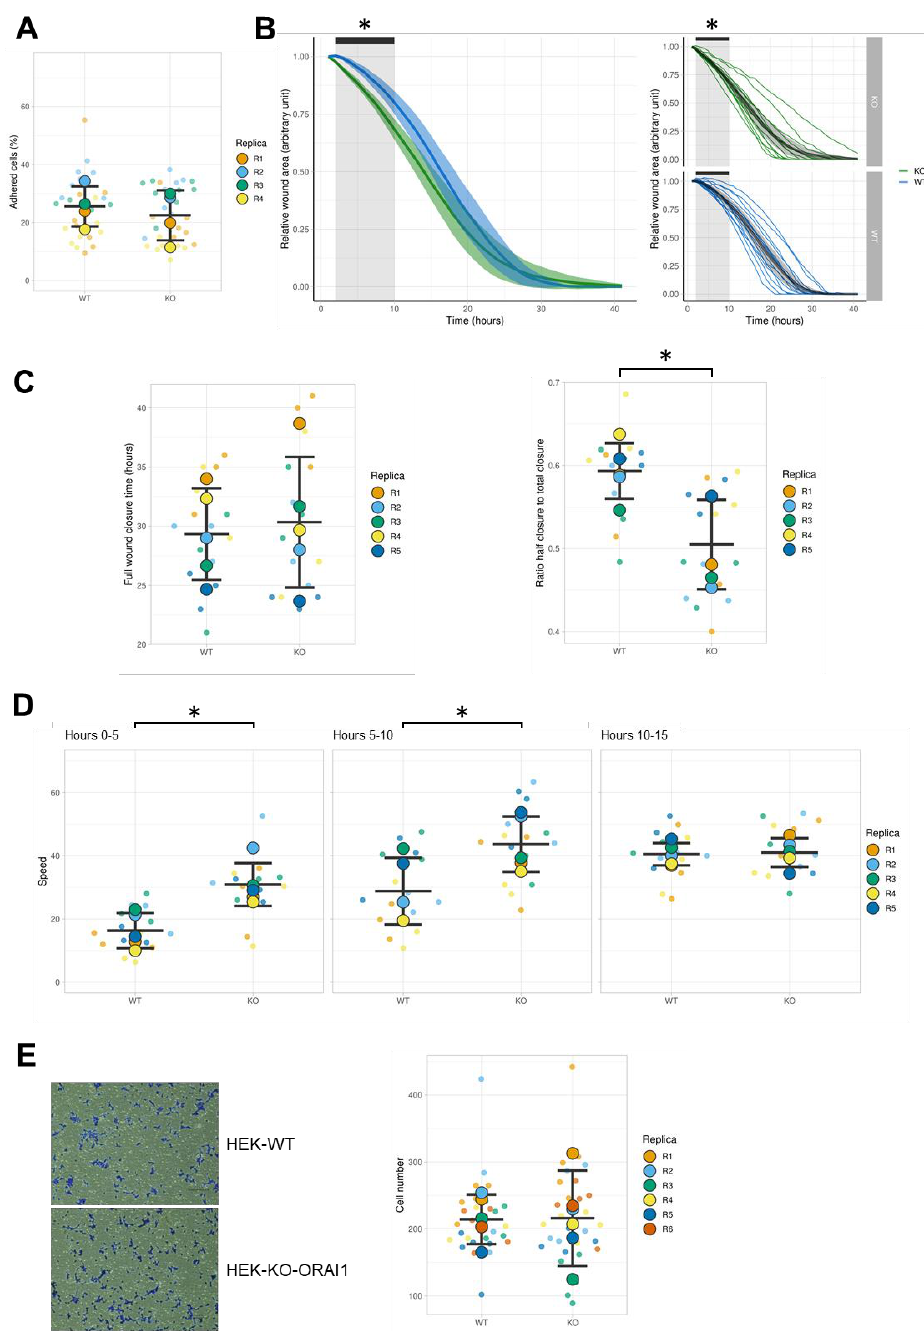
Figure 6. ORAI1 knockout (KO) modifies HEK-293 cell migration properties. ( A ) Comparison of the adhesive properties of wild type (WT) and ORAI1 KO cells. Data points represent the percentage of adhered cells after an incubation for 1 h at 37 °C. Plain circles represent the mean values of individual replicates (R1, R2, R3, and R4); semitransparent circles display individual data points within each replicate. The mean values of the four replicates are indicated as black bars ± standard deviation (CI). The difference in adhesion between WT cells (25.56% ± standard deviation [SD] 6.90%) and KO ORAI1 cells (22.49% ± 8.61%) was assessed with Welch’s t -test for nonpaired data and was not significant ( p = 0.6; mean difference between conditions = − 3.07% with a 95% CI of − 16.73 to 10.59). ( B ) Middle panel: relative wound area as a function of time (WT in blue, ORAI1 KO in green). The curves represent the means of five independent experiments with their 95% CI (semitransparent colors). Right panels: Relative wound area as a function of time with each repeat presented individually (down panel: WT in blue; top panel: KO in green). Black lines represent the mean value of the experiments with the 95% CI in semitransparent color; the thin colored lanes represent repeats of every single experiment performed. Wound